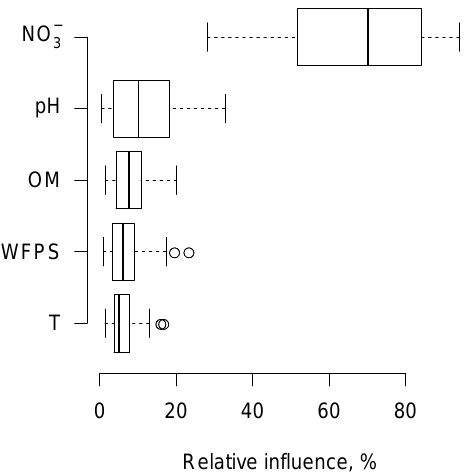
Fig. 5. Boxplot (description of quartiles with maximum at 1.5 interquartile range) of relative influences of the 5 input variables, as revealed by the ANN5(OM,pH)G model. Circles are outlier